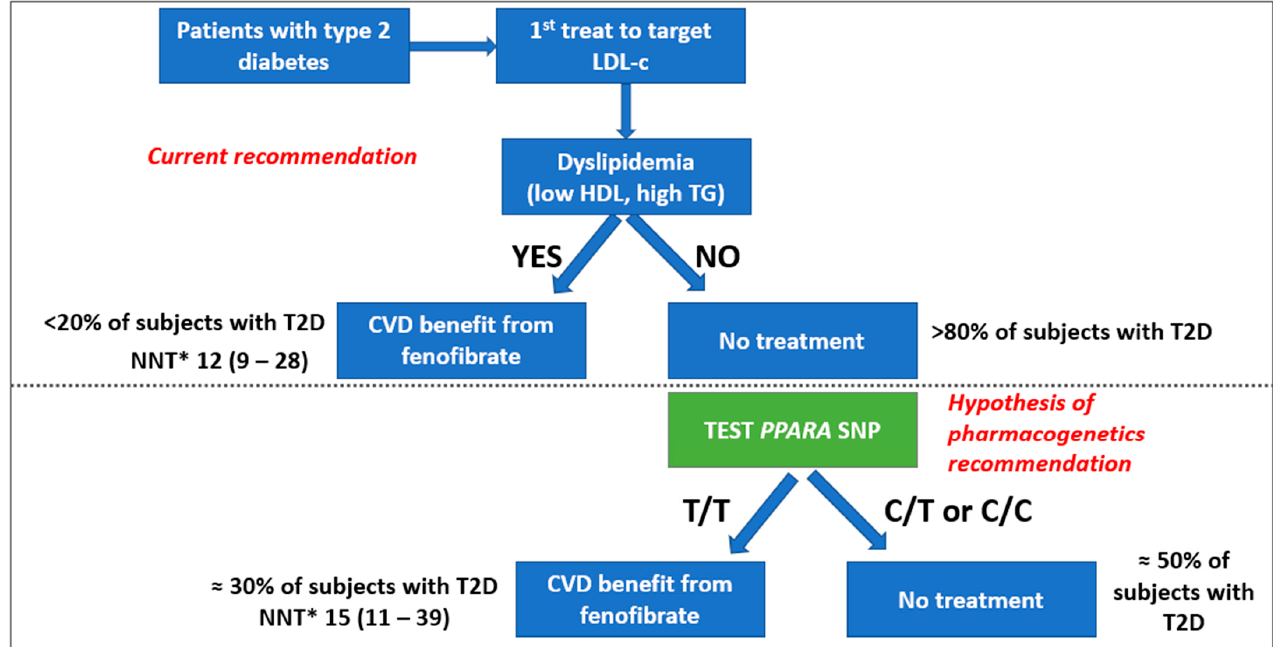
Figure 4. Graphical representation of the hypothesis of pharmacogenetic recommendation to im- prove the identification of subjects with type 2 diabetes that might have cardiovascular benefit from fenofibrate treatment (* NNT = number needed to treat at 5 years to prevent one MACE, estimated from the population of the ACCORD clinical trial).